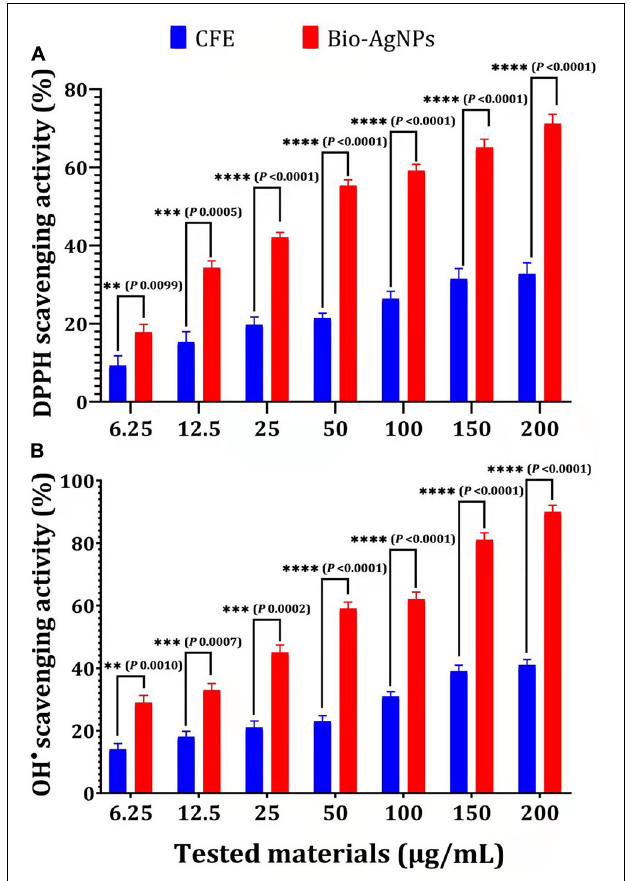
FIGURE 10 | Antioxidant capacity of different concentrations of CFE and Bio-AgNPs. (A) DPPH radical scavenging activity. (B) OH - radical scavenging activity. The data are represented in the form of a bar graph and plotted using mean ± SE of three replicates. P -values for significantly different mean values, P < 0.01 ( ∗∗ ), P < 0.001 ( ∗∗∗ ), P < 0.0001 ( ∗∗∗∗ ).